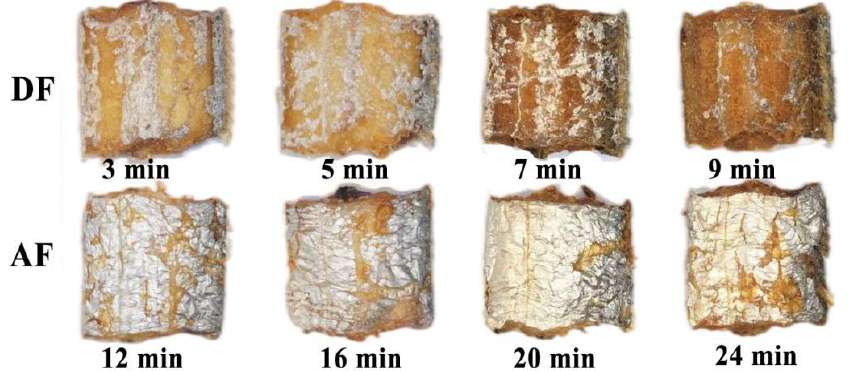
Figure 1. Photos of DF and AF at different thermal time